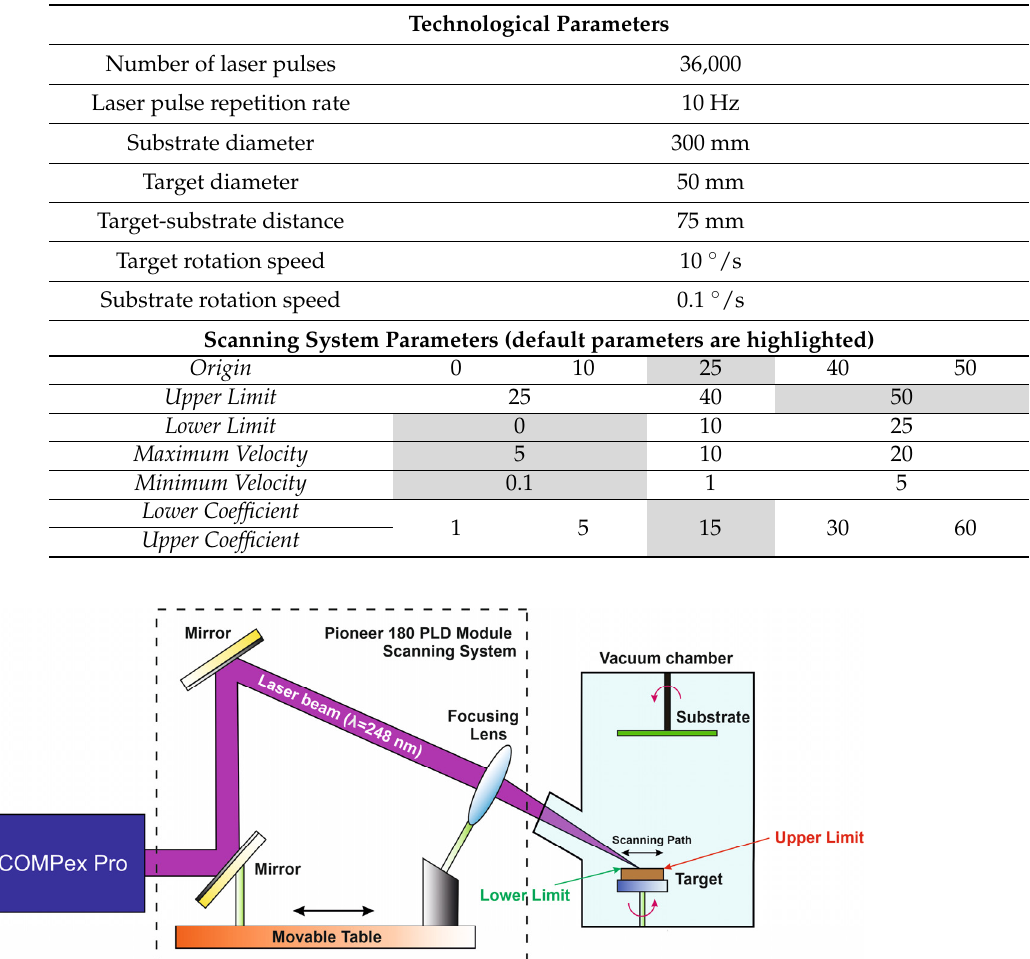
Table 1. Modeling parameters.